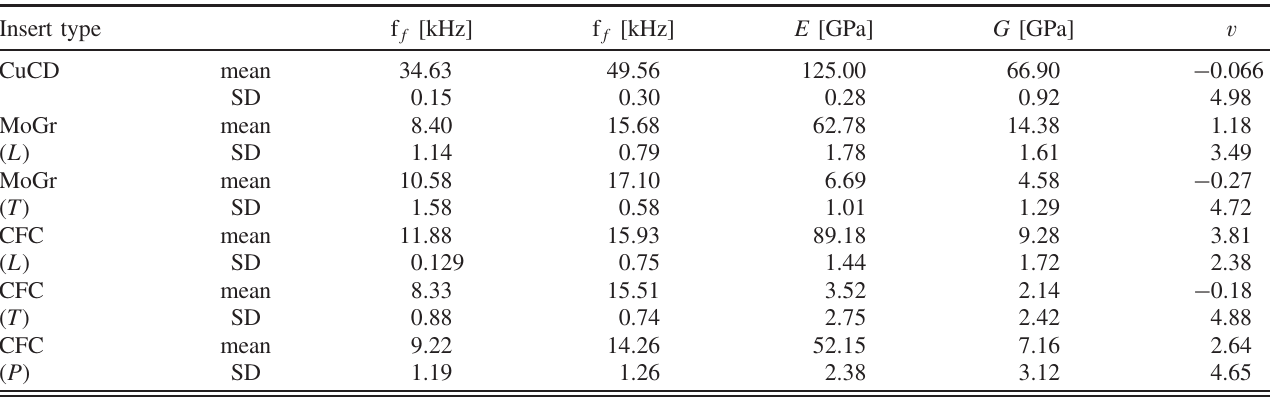
[Hz], torsional frequency f [Hz], and elastic parameters, including elastic f t